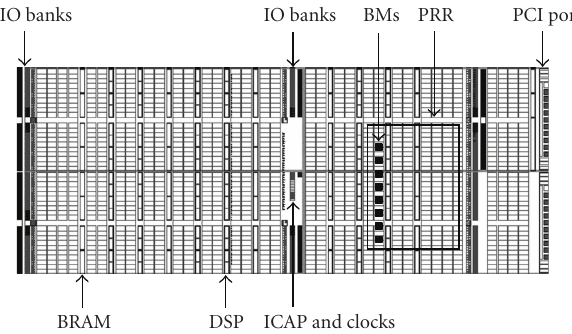
Figure 1: View of a Xilinx Virtex5 5VSX50T FPGA captured from the PlanAhead Xilinx software